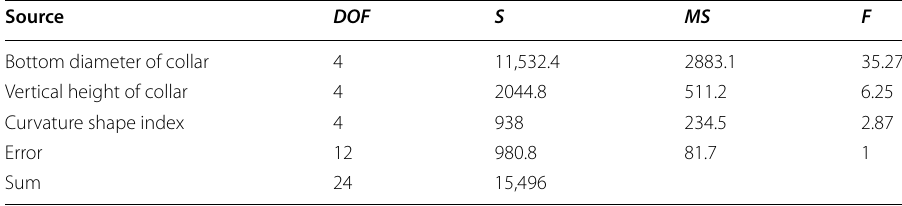
Table 6 Analysis of variance for maximum scour depth Source DOF S MS F Bottom diameter of collar 4 11,532.4 2883.1 35.27 Vertical height of collar 4 2044.8 511.2 6.25 Curvature shape index 4 938 234.5 2.87 Error 12 980.8 81.7 1 Sum 24